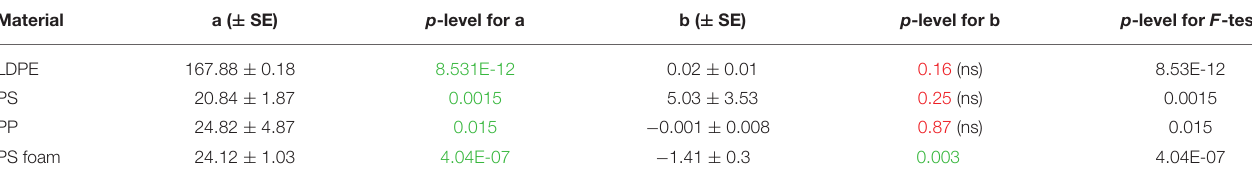
TABLE 6 | Parameters of linear regression ( y = a x + b ) for a relationships between the mass of MPs and the number of MPs particles. Material